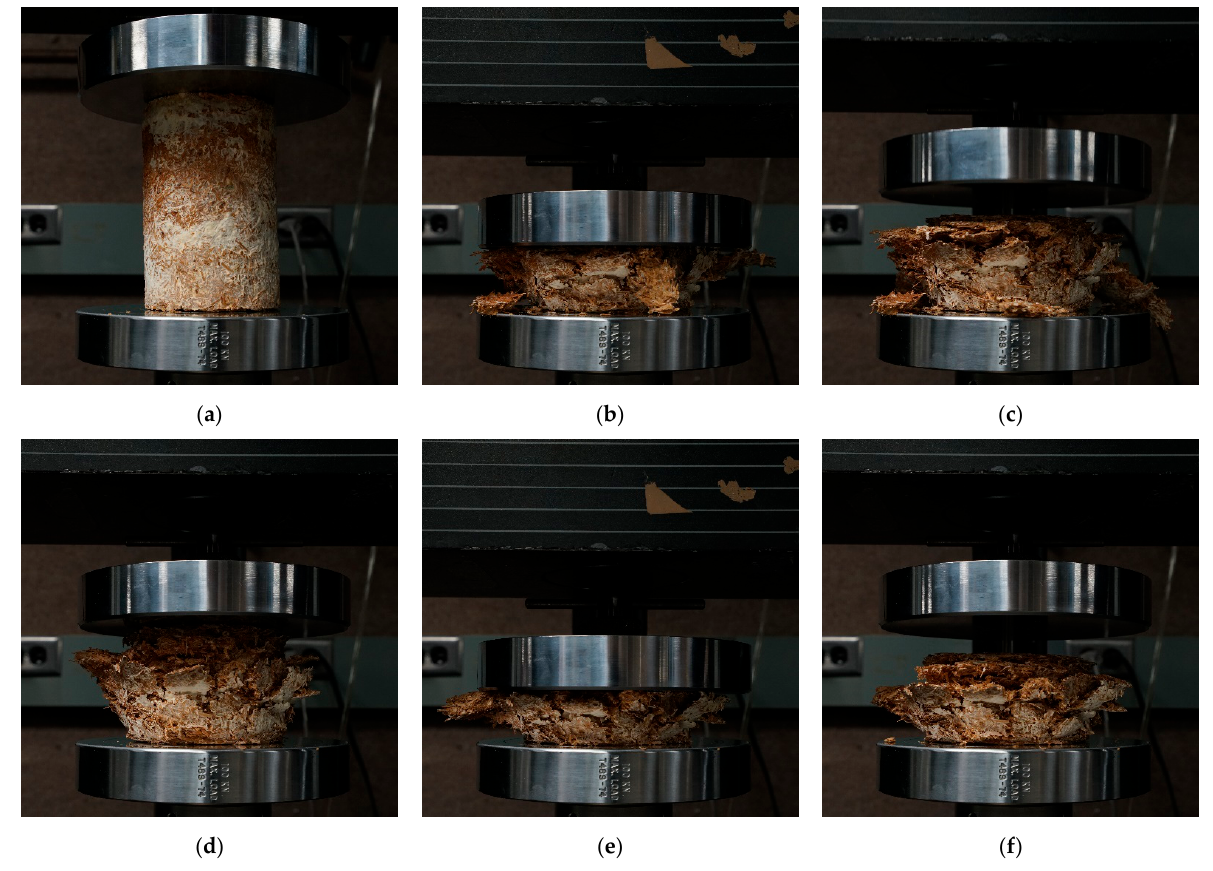
Figure 5. This figure shows the deformation of a specimen throughout the compression test: ( a ) beginning of the test; ( b ) end of the first test where a compressive strain of 0.75 was reached; ( c ) 5 s after removing the load from the first test; ( d ) 10 min after removing the load from the first test which equals the beginning of the second test; ( e ) end of the second test where a compressive strain of 0.62 and a load of 10 kN were reached; ( f ) 5 s after removing the load from the second test. Table 4. This table shows relative humidity before testing, density, and the modulus of elasticity calculated by the Instron and from the ASTM D1037 formula (bold). It also presents the maximum load sustained by all samples, the distance between the center of the specimen and the fracture location (i.e., fracture offset from center), and the angle of that fracture in comparison to the axis of the bending supports. The letter “I” in the sample name means that the corresponding specimens were grown as an extra under different growth environments, mold sizes, and timelines. Acronyms for each sample are labeled in Table